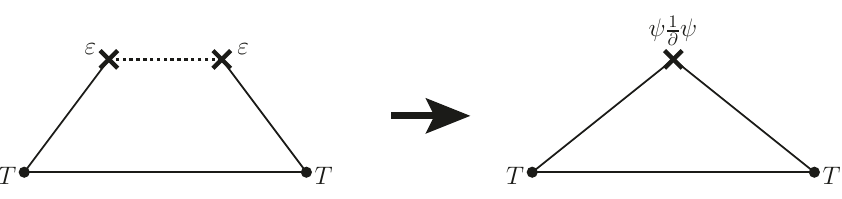
Figure 4 . Using our prescription, the Ising four-point function matrix element involving the e(cid:11)ective interaction 1 of (cid:14) ( x + ) in the (cid:31) propagator (dashed line). However, let’s look more carefully at the next contribution in this series, due to the four- point